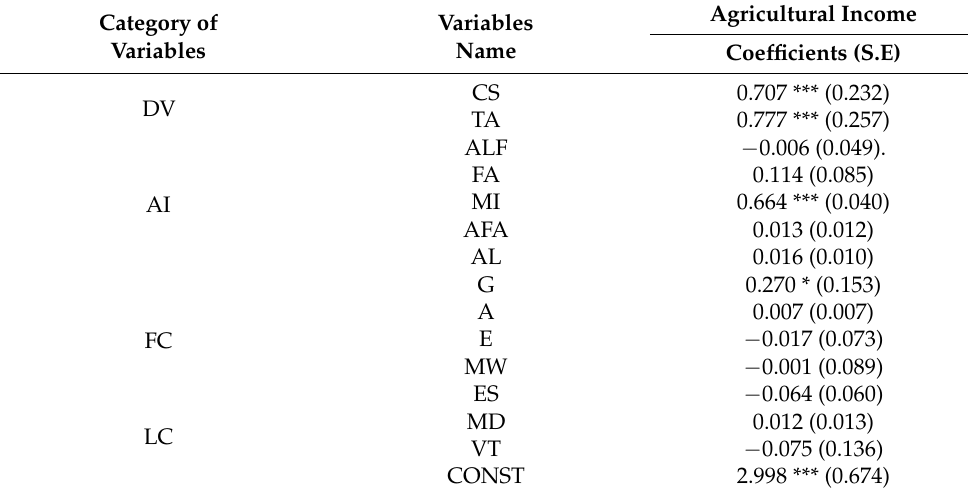
Table 8. DSM’s second step regression outcomes and low-revenue